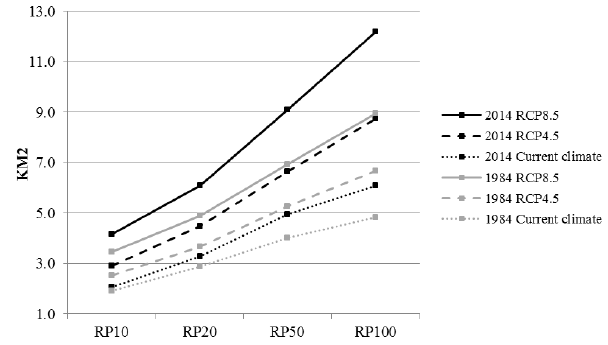
Figure 3. Total area flooded by > 10cm of surface water during high-intensity precipitation events for present (2014) and histori- cal (1984) land cover conditions and for current climate and RCP85, 1984=imperviousness of 32%, 2014=imperviousness of 51%.